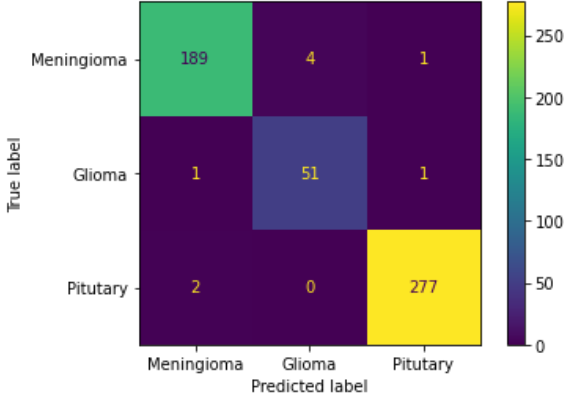
Figure 11. Confusion matrix. Table 2. Comparison on different